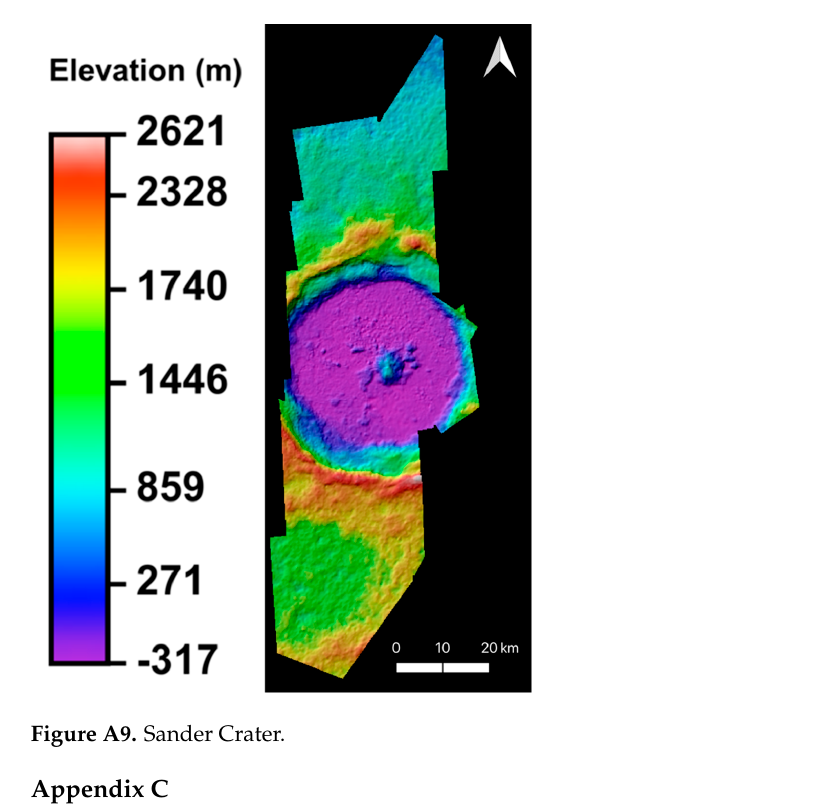
Figure A8. Hollows in Raditladi Basin.